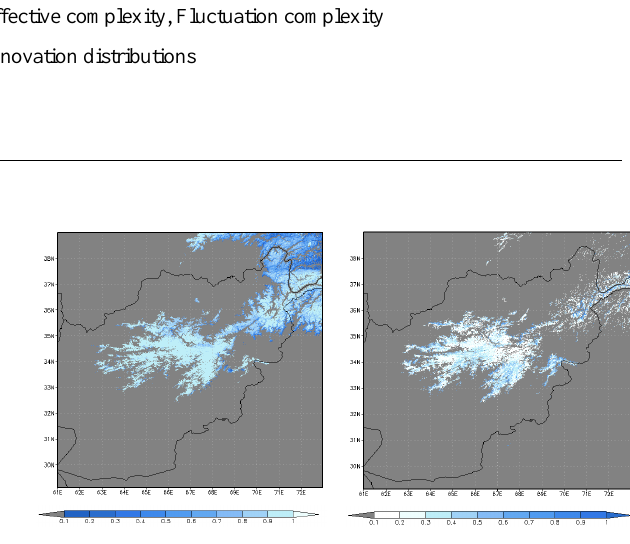
Fig. 4. Probability of Detection (left column) and False Alarm Ratio (right column) of the model simulated snow cover fields compared against the fractional MODIS snow cover product